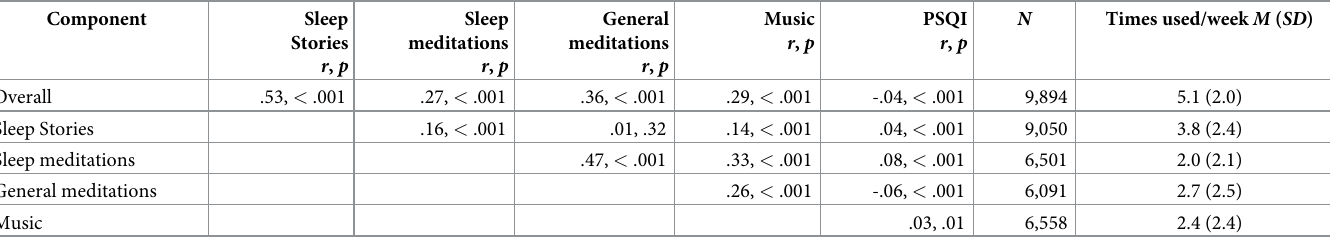
Table 3. Correlations between frequencies of using individual Calm components.